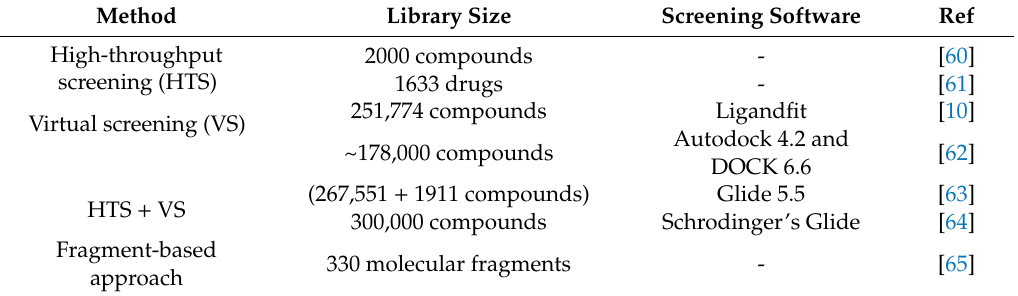
Table 1. Comparison of di ff erent strategies used in the screening of Nrf2–Keap1 PPI inhibitors.